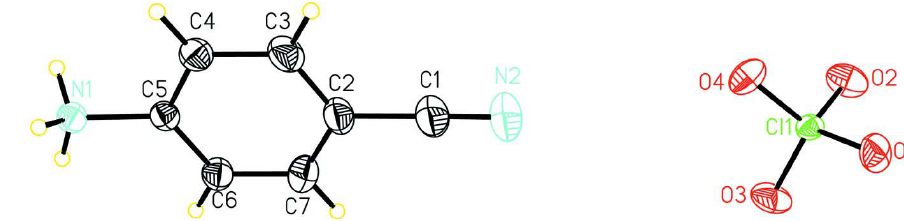
A view of the title compound with the atomic numbering scheme. Displacement ellipsoids were drawn at the 30% probability